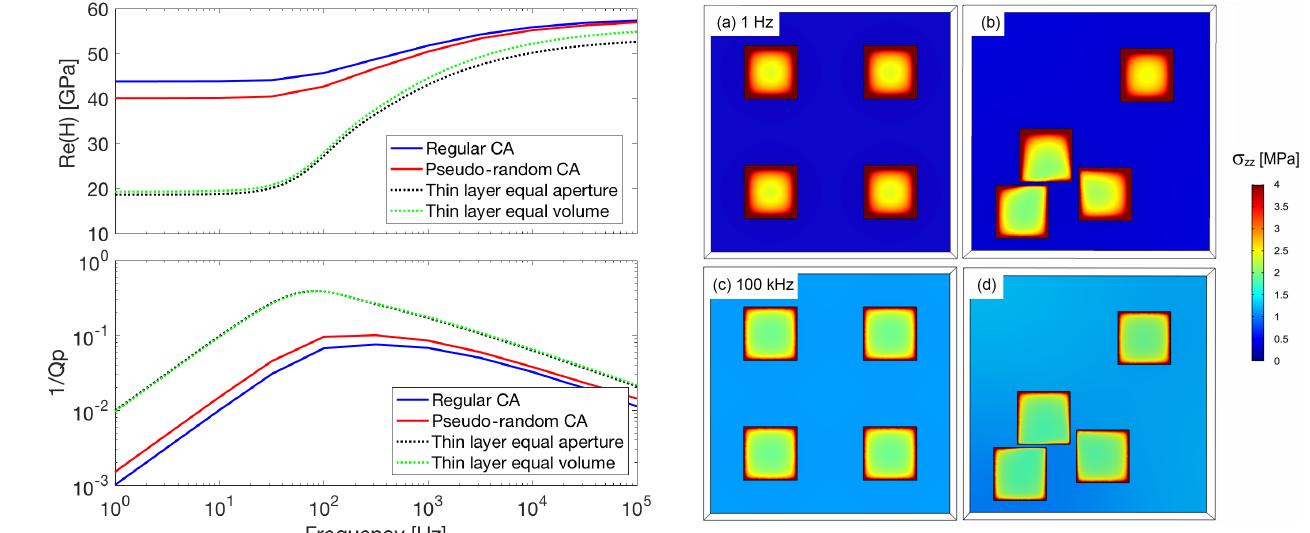
Figure 3. Real part of P-wave modulus ( H ) and attenuation as a function of frequency for wave propagation normal to the fracture models illustrated in Fig. 2. We also include White’s solutions for two thin layer models having equal aperture and equal volume, re- spectively, of the open region of the fractures in Fig. 2.